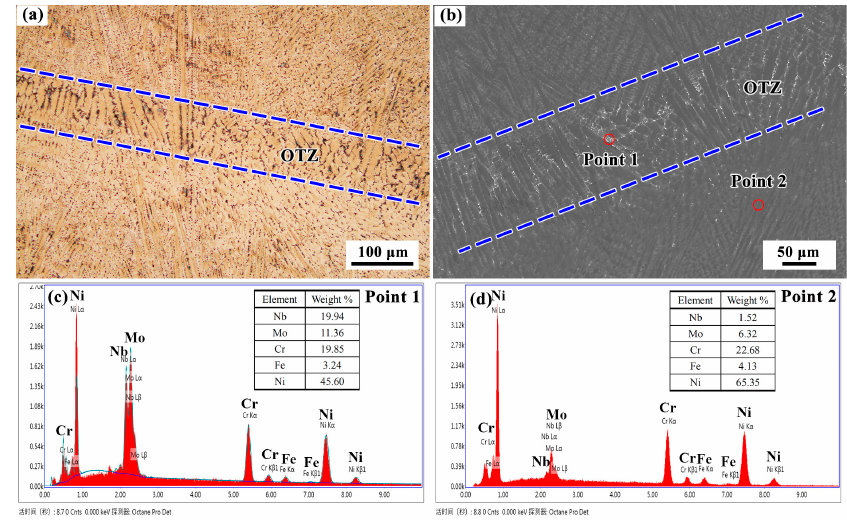
Figure 11. ( a ), ( b ) Microstructures of OTZ and the ( c ) EDS results of Laves and ( d ) matrix phases.